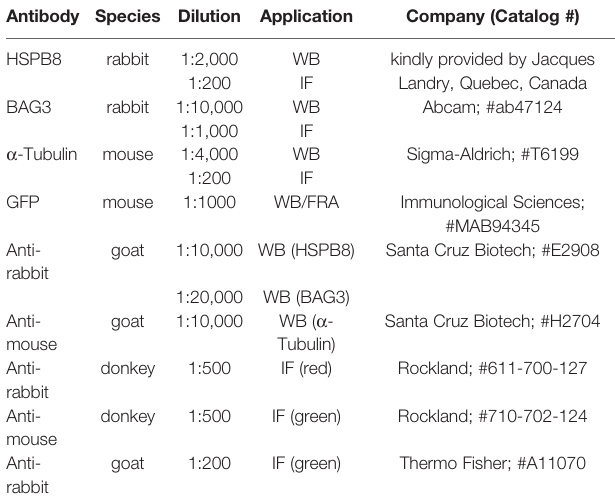
TABLE 3 | Antibodies